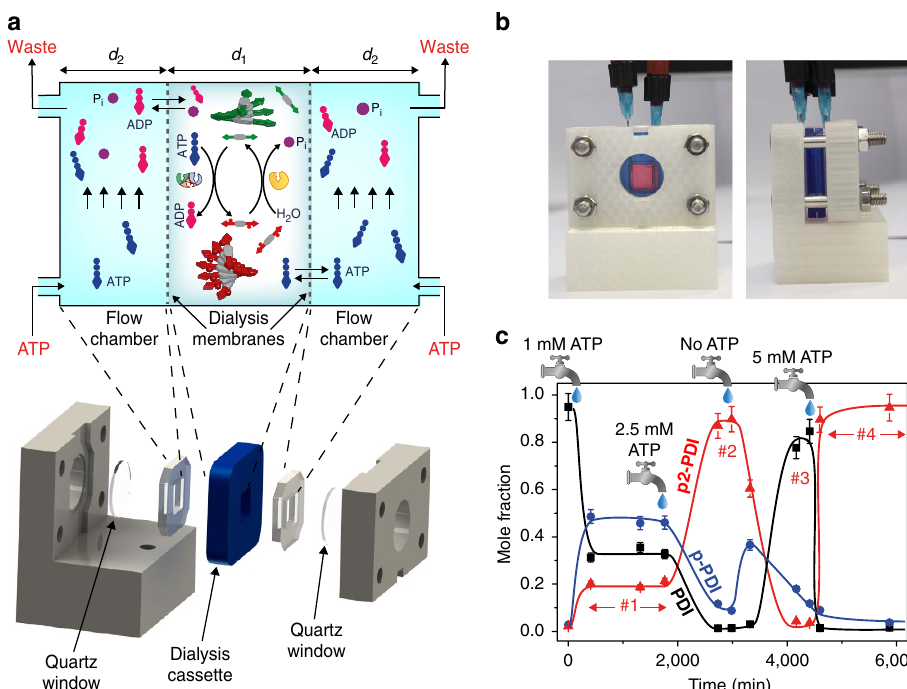
Figure 4 | Continuous flow device and supramolecular non-equilibrium steady states. ( a ) Principle of operation and CAD design of the continuous flow device based on a clamped dialysis cassette. The average gap between the membranes d 1 is 1.9mm, the width of the flow chambers d 2 5.1mm. ( b ) Front and side view of the three-dimensionally (3D) printed device, also showing the inlet and outlet needles inserted through the silicon spacers. ( c ) Different NESS (plateau regions, no. 1 (cid:2) 4), characterized by different molar fractions of the three species PDI , p-PDI and p2-PDI (by LC–MS analysis), can be obtained using the continuous flow device, depending on the influx of the fuel ATP. Solid lines are drawn to guide the eye. The taps are placed in correspondence of the time(s) at which we changed the ATP concentration of the solution that is continuously flowed through the lateral flow chambers. Namely, at t ¼ 50min we started to flow ATP 1mM, at t ¼ 1,770min we switched to ATP 2.5mM, at t ¼ 3,170min we started to flow buffer without ATP and at t ¼ 4,440min we switched to ATP 5mM. For all NESS experiments: 0.085 m M PKA and 0.097 m M l PP. The error bars were set to 6% of the corresponding value. The latter is the maximum error observed in the determination of the molar fraction when injecting 3 times in LC–MS solutions of known